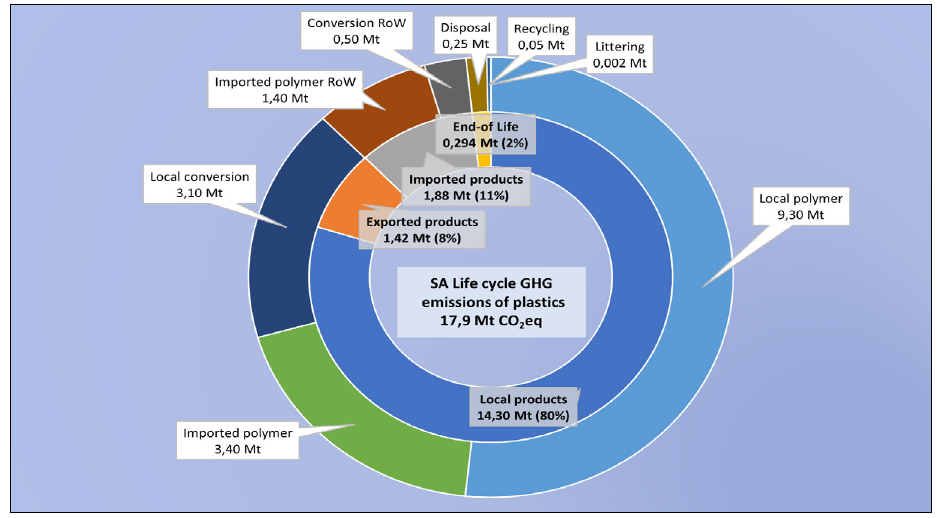
Figure 3: Estimate of the life cycle-based carbon footprint of plastics in South Africa for 2018. Table 2: Projected flows in the South African plastics value chain for 2025